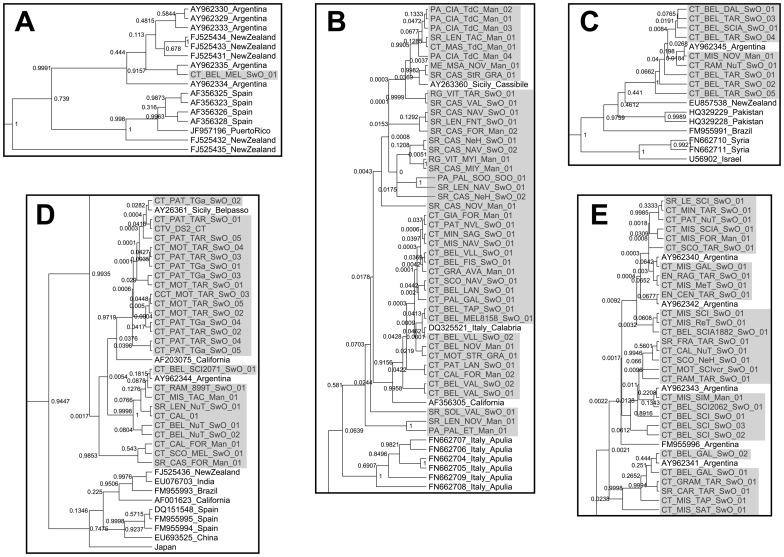
Parts of a Bayesian phylogenetic tree indicating the five clades (A, B, C, D, and E) containing CTV isolates from Sicily.
Figure S1 shows all the clades; including also those without the Sicilian isolates. The sequences determined in this work are highlighted in grey background. Node significances are indicated by Bayesian posterior probabilities.